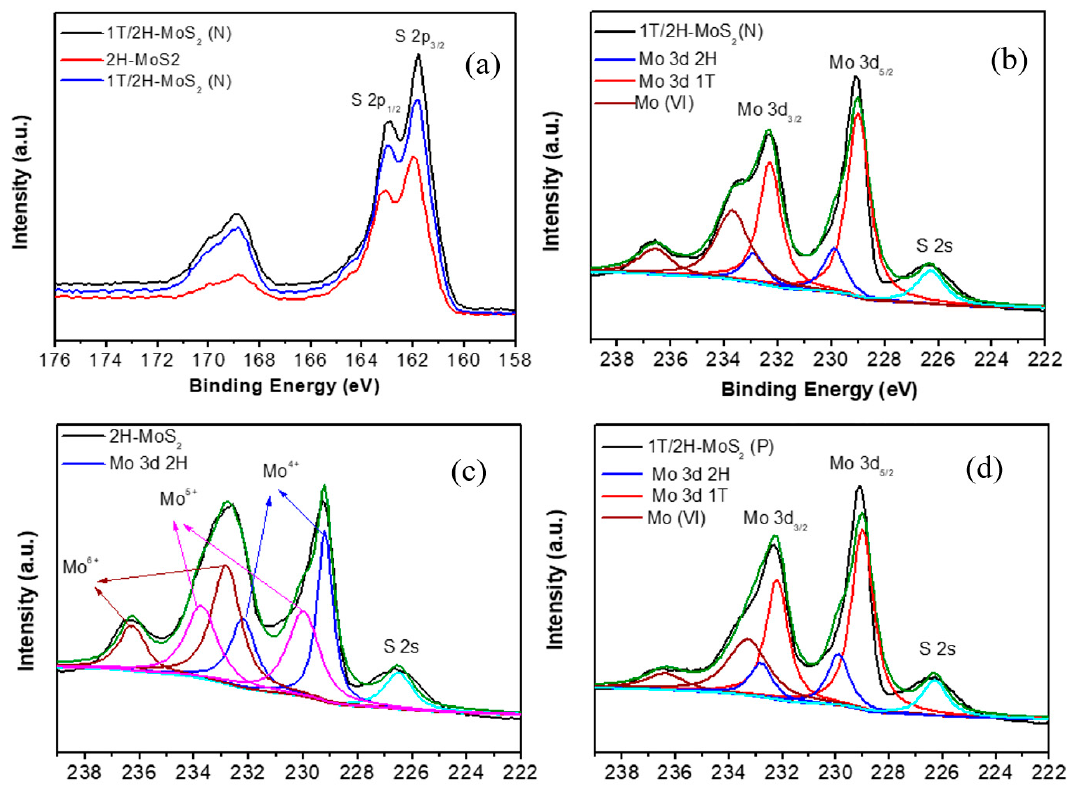
Figure 5. ( a ) S 2p XPS spectra of 1T / 2H-MoS 2 (N), 2H-MoS 2 , and 1T / 2H-MoS 2 (P); ( b ) Mo 3d XPS spectrum of 1T / 2H-MoS 2 (N); ( c ) Mo 3d XPS spectrum of 2H-MoS 2 ; ( d ) Mo 3d XPS spectrum of 1T / 2H-MoS 2 (P).